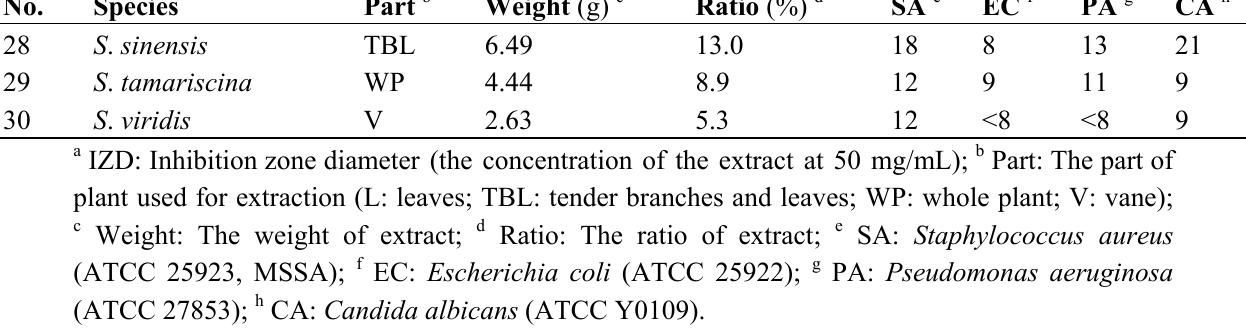
Table 4. Comparison of IZDs of the 21 extracts against MRSA and MSSA strains (IZD: mm) a . No.